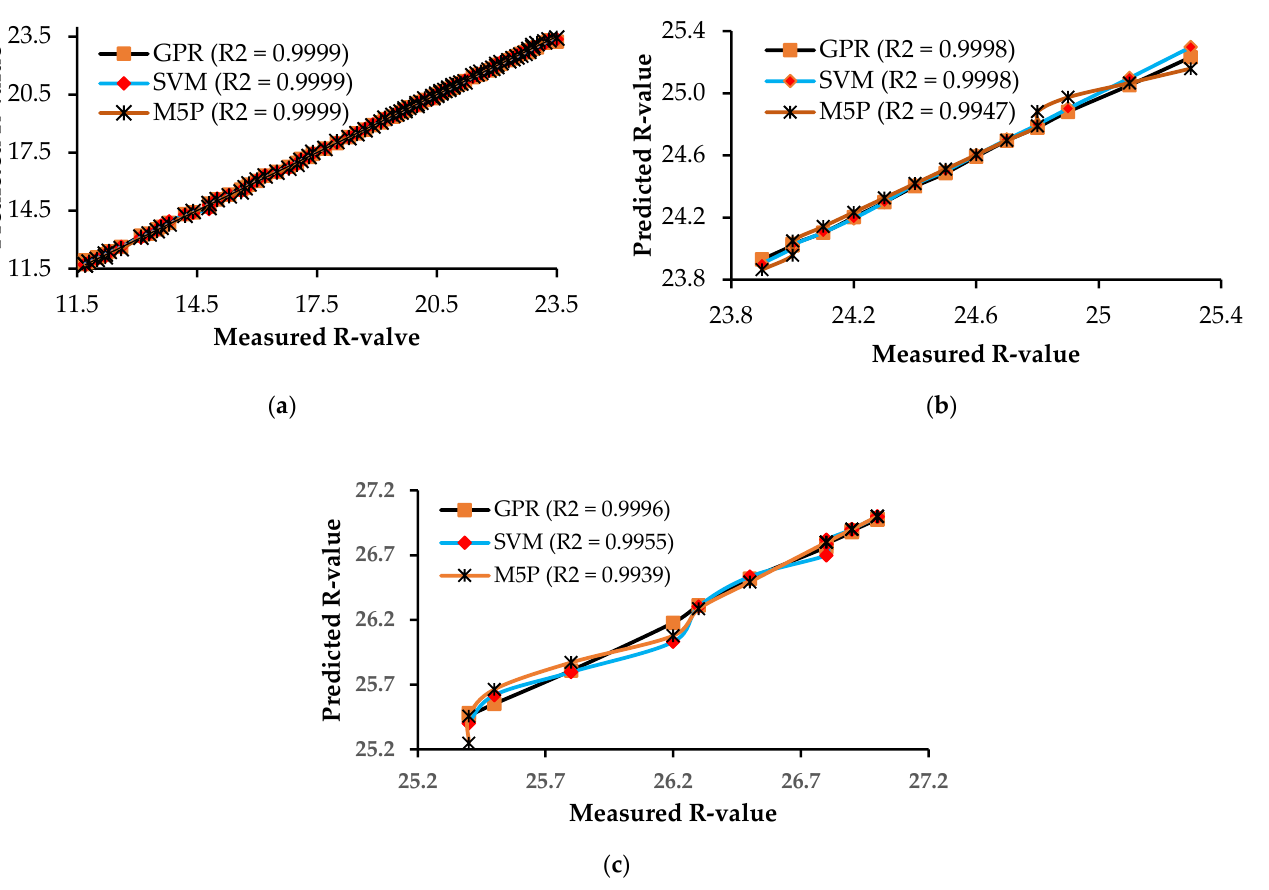
Figure 3. Comparison of measured R-value and predicted R-value in ( a ) training set, ( b ) testing set, and ( c ) validation set.